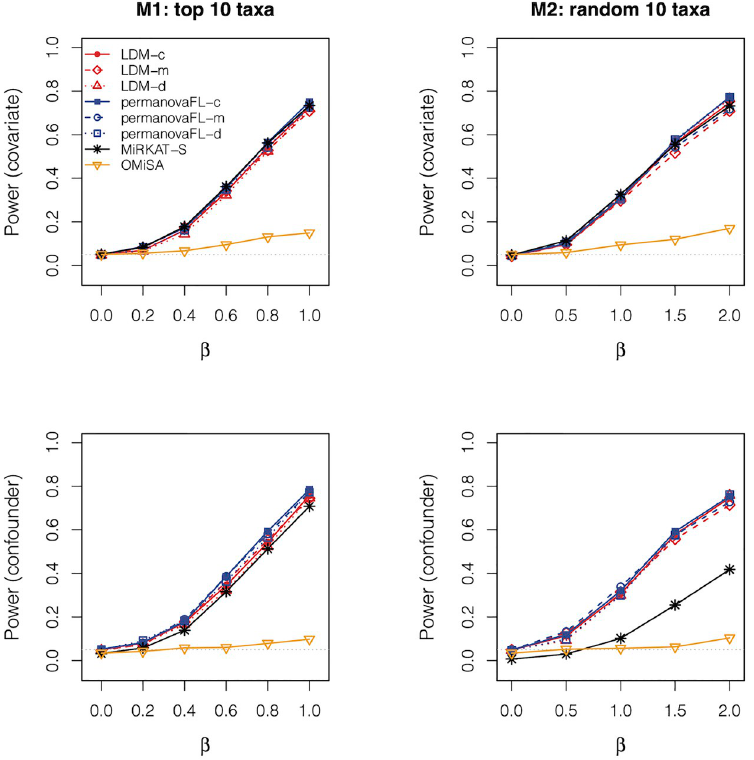
Fig 2. Power of the global tests in the presence of a covariate ( β XZ = 0) and a confounder ( β XZ = 0.8). The data were simulated with 50% censoring and n = 100. The gray dotted line represents the nominal type I error level